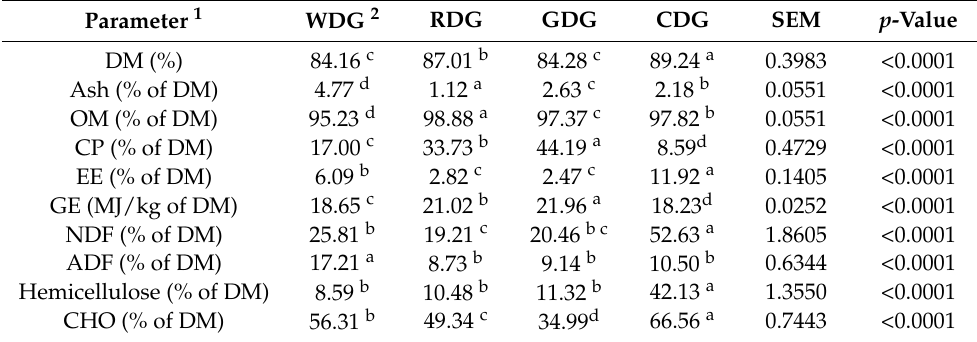
Table 1. Chemical composition of four types of distiller’s